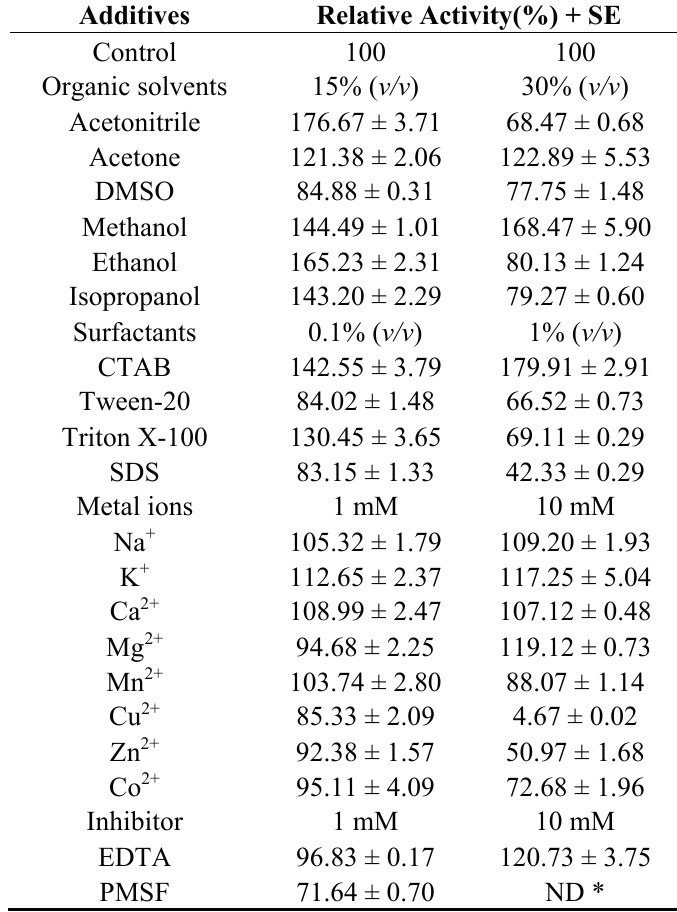
Table 3. Effects of organic solvents, surfactants, metal ions, and inhibitors on the activity of